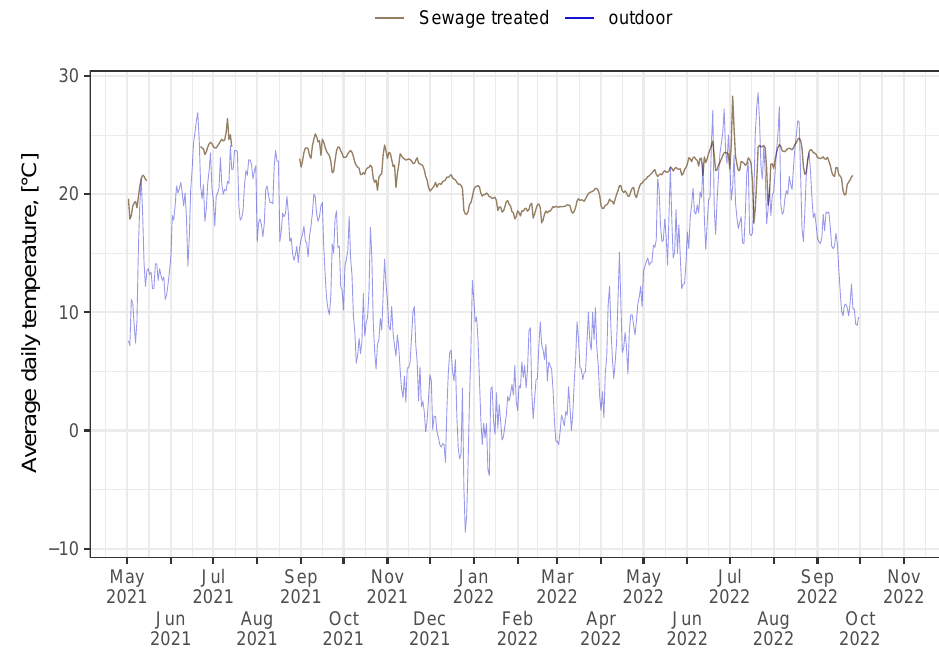
Figure 4. Hourly average temperature values of treated wastewater during the research. The temperature of the treated sewage was measured in a dedicated measuring tub at the exit of the sewage treatment plant. The measurement was carried out by means of an immersion temperature sensor integrated with a pH measuring probe. The measurement sample was taken from the sewage discharge canal to the receiver (river), and then pumped to the measurement site (measuring tank). The flow of the treated sewage was carried out by means of an ultrasonic flow meter, which consists of a transducer, speed sensor, and height sensor, and is located directly on the sewage discharge canal of the receiver. This flow meter is calibrated